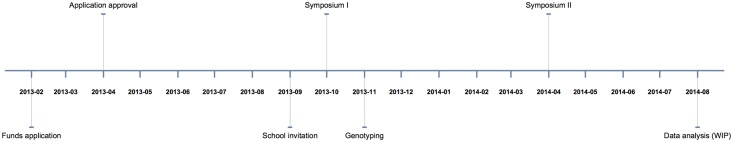
Timeline of the Where Are You From? project.